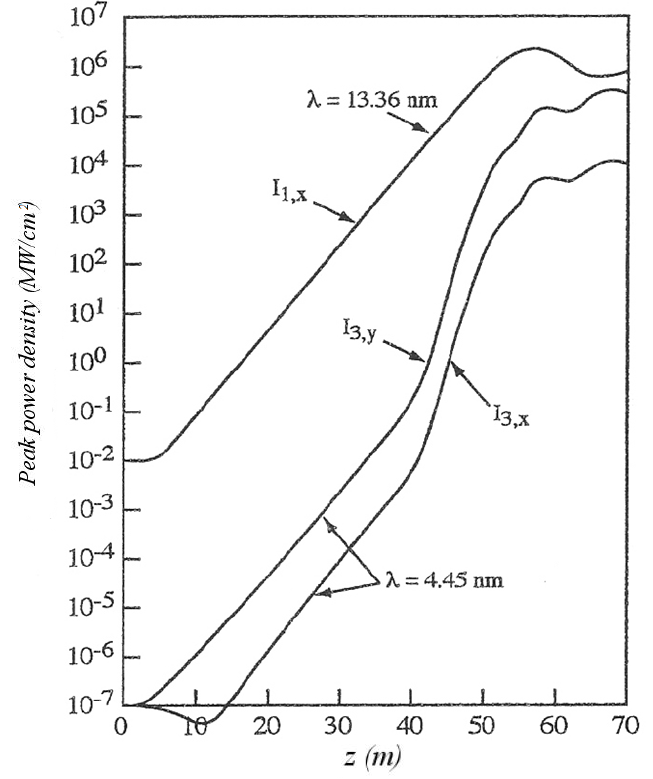
Figure 2. Power growth of main and third harmonics for a bi-harmonic undulator with, E = 1078 Mev, λ u = 6 cm, K = 0.99, ρ = 1.258 × 10 − 3 (numerical simulation